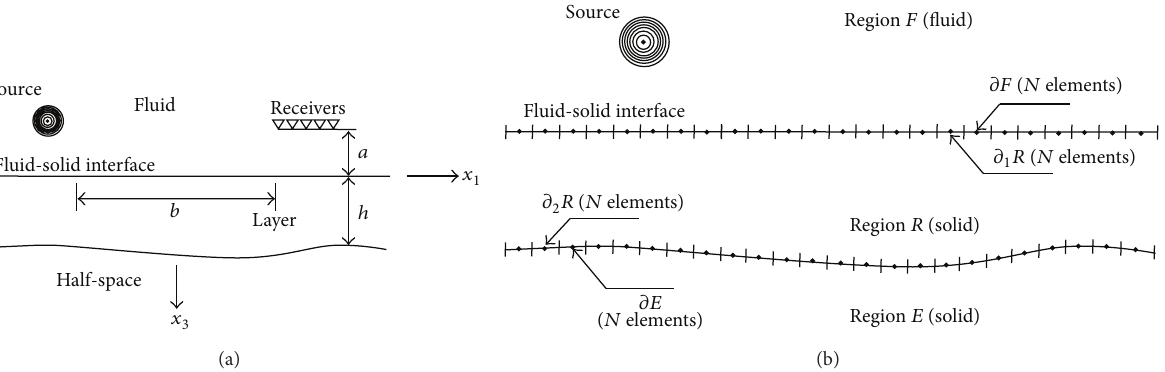
Figure 2: (a) Fluid-layered solid interface excited by a source in the fluid; (b) mesh used to solve the problem with boundary element.